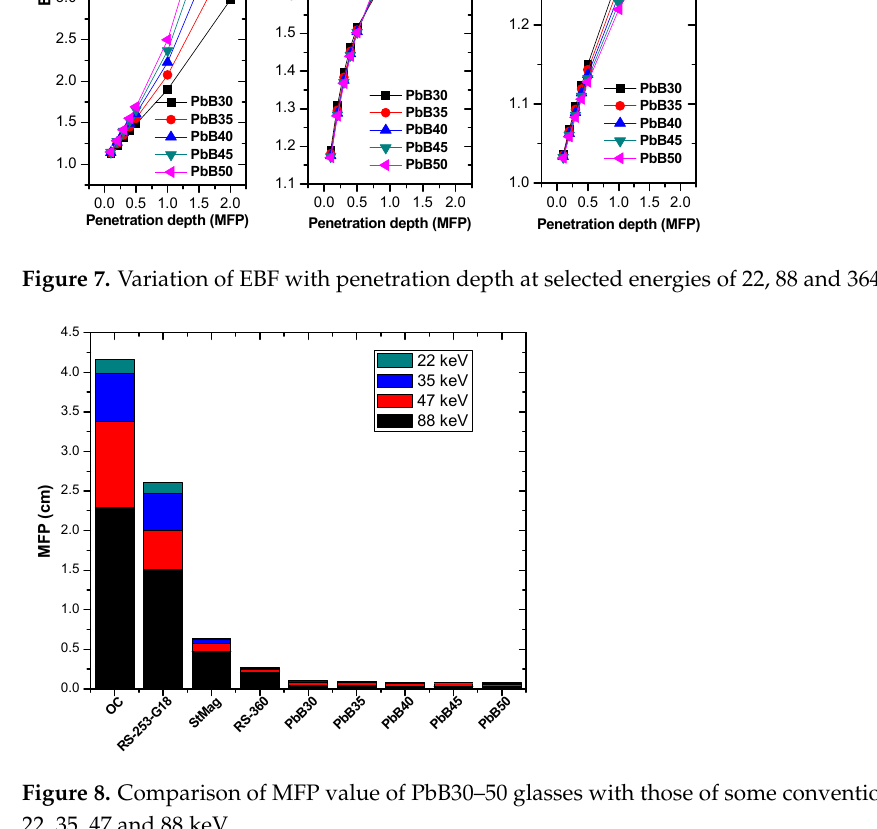
Figure 8. Comparison of MFP value of PbB30–50 glasses with those of some conventional shield at 22, 35, 47 and 88 keV.